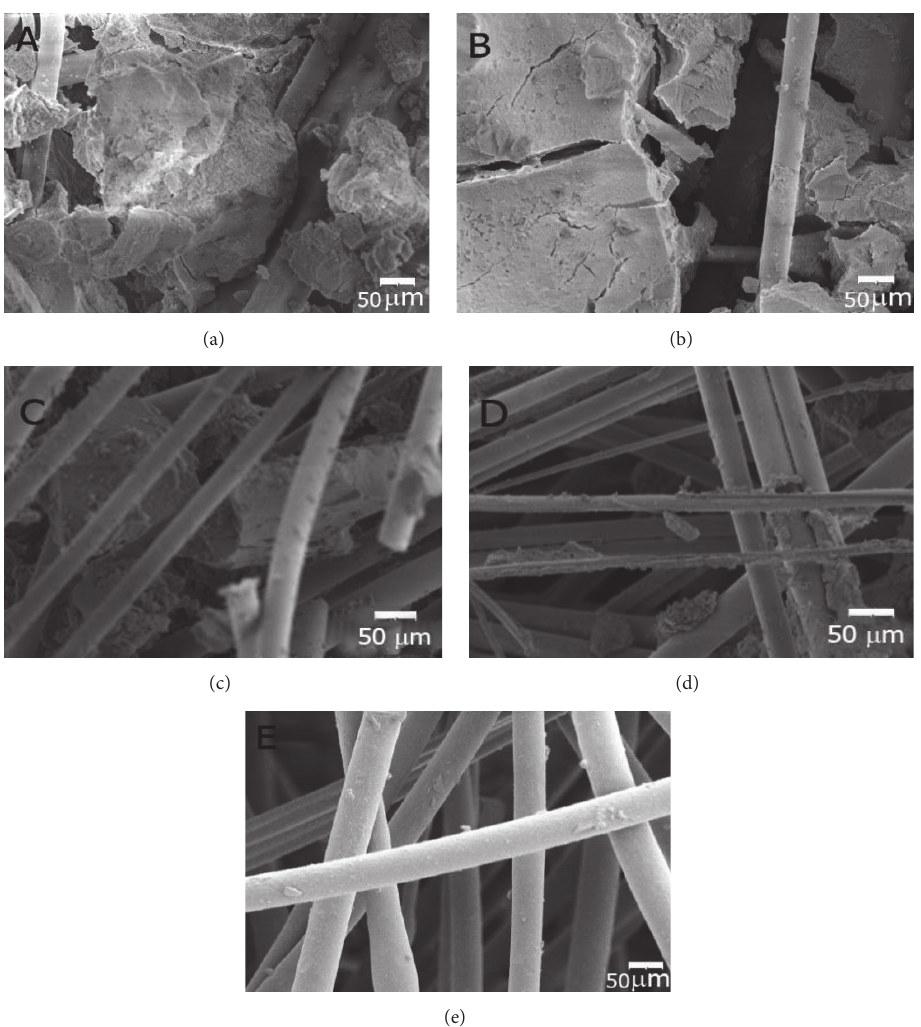
Figure 2: SEM images of different loaded Maerogel on glass wool: (a) case 4 , (b) case 3, (c) case 2, (d) case 1, and (e) OGW without loaded